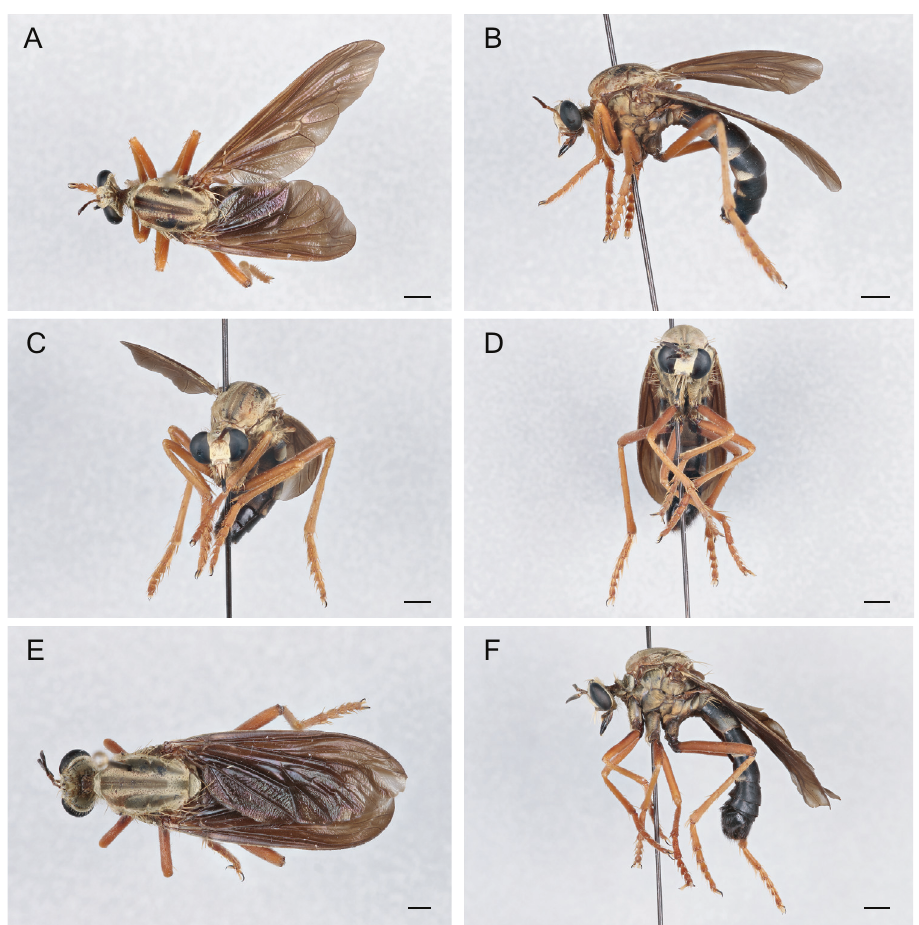
Figure 20. Saropogon pritchardi Bromley, 1934 Female (UCBMEP0280596): A dorsal view B lateral view C anterior view; Male (UCBMEP0280595): D anterior view E dorsal view F lateral view. Scale bars: 2